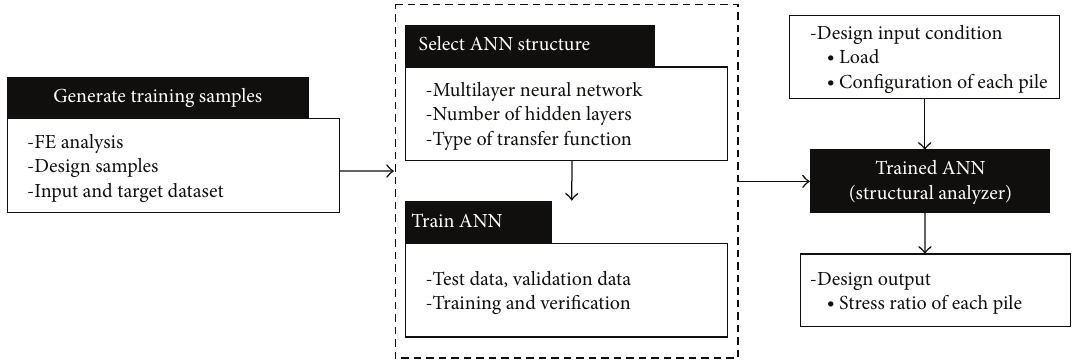
Figure 1: Methodology of design process using